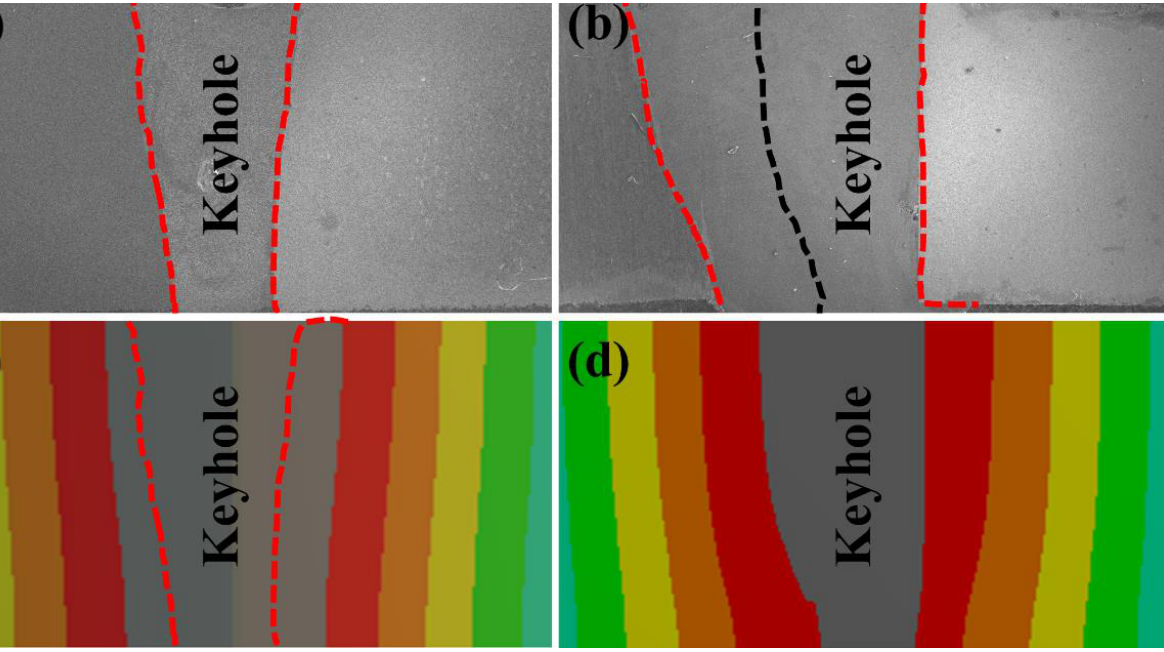
Figure 11. Cross-section of brazed joint ( a ) B 1 and ( b ) V 1 obtained by experiment and ( c , d ) the corresponding simulation results.